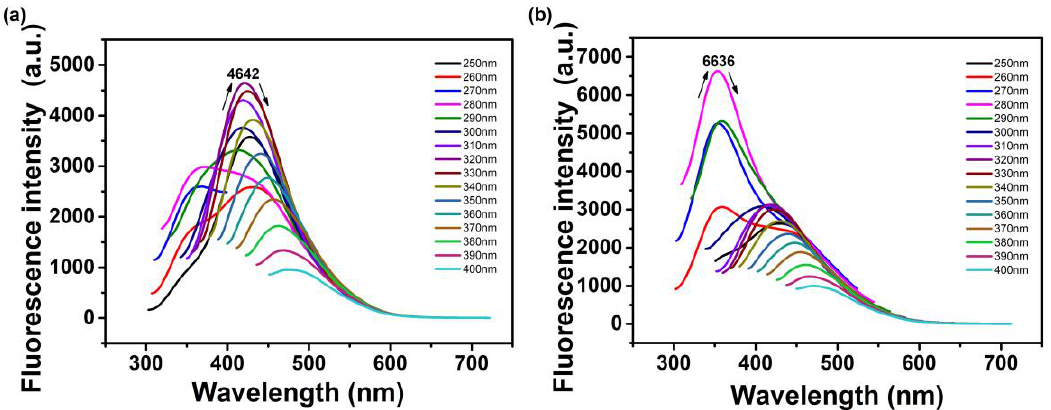
Figure 5. UV-Vis spectrum of ON-CQDs (black) and WN-CQDs (red).